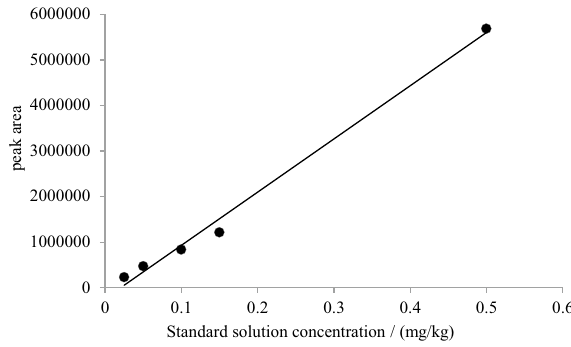
Figure 3. Standard curve of fluopyram solution.